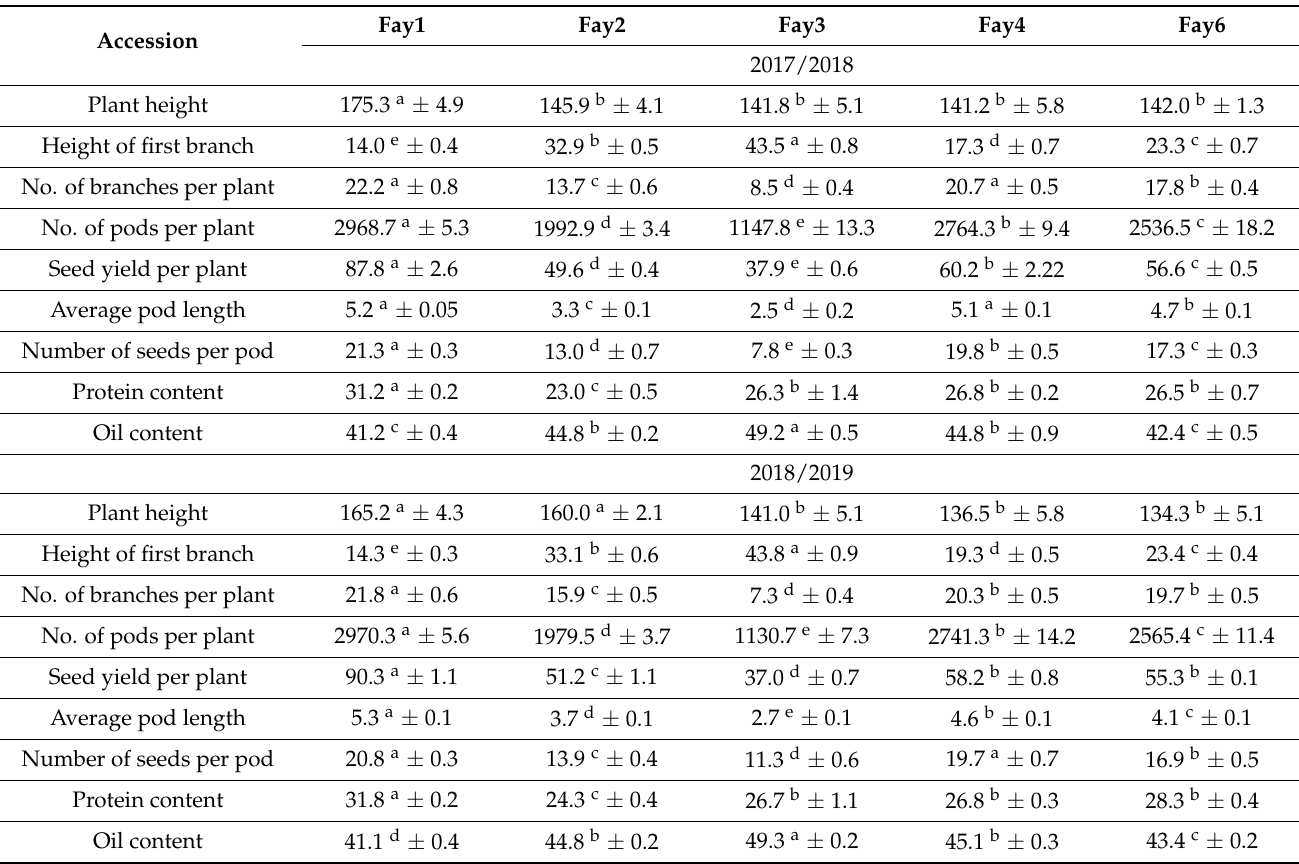
Table 1. Plant height (cm), height of first branch (cm), number of branches and pods per plant, seed yield per plant (g), length of pods (cm), and number of seeds per pod, as well as protein and oil contents (%) of the evaluation Brassica accessions for two growing